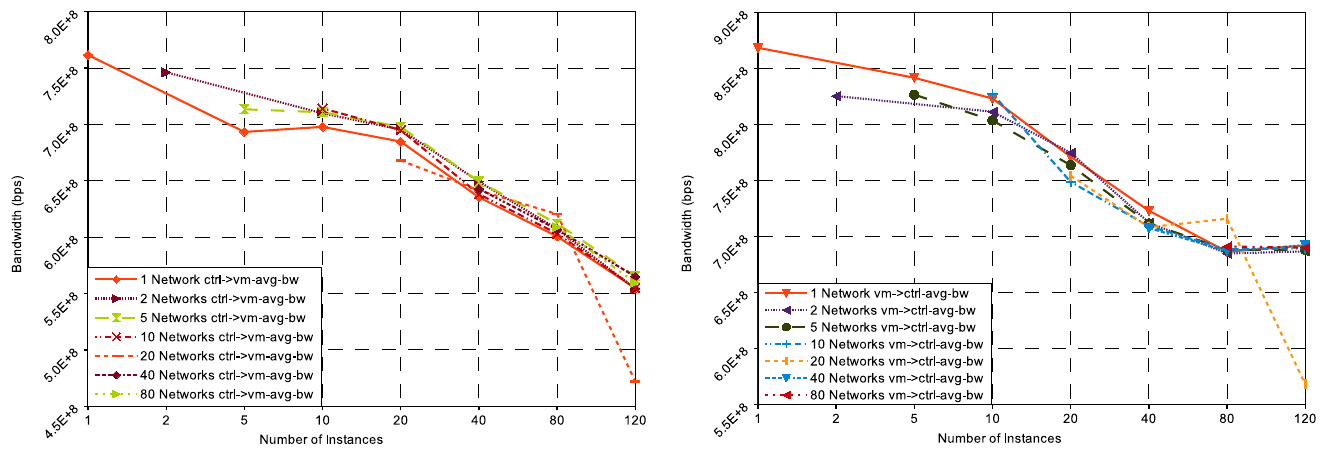
Fig. 7: TCP bandwidth breakdown for